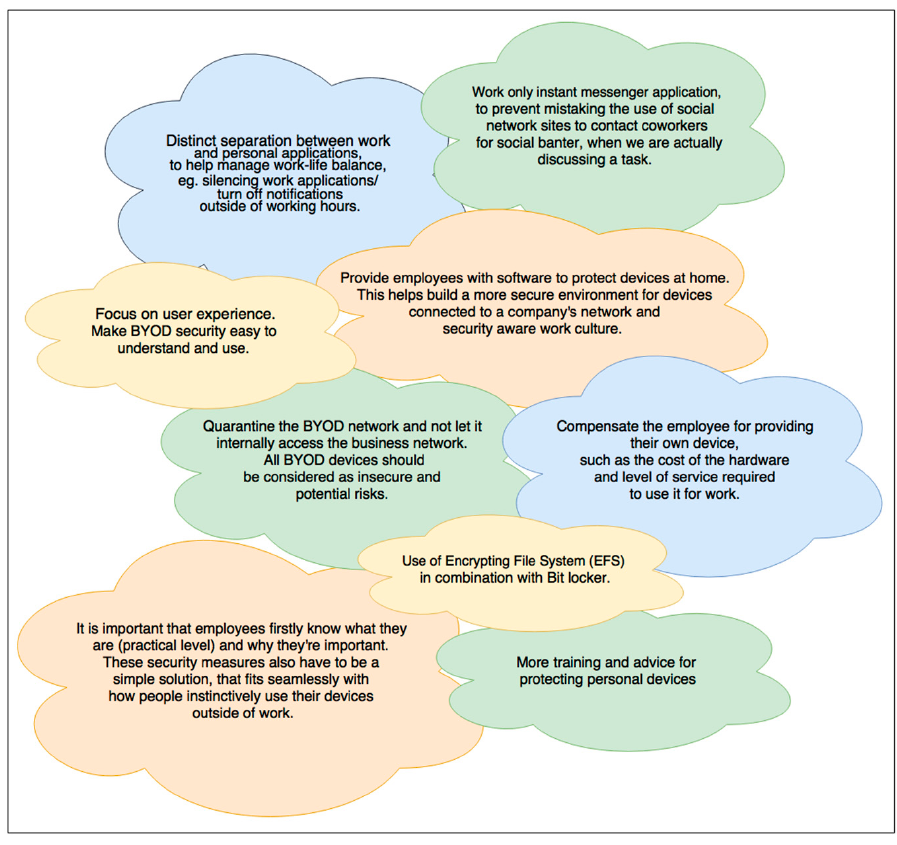
Figure 6. Employee suggestions for improving BYOD security at